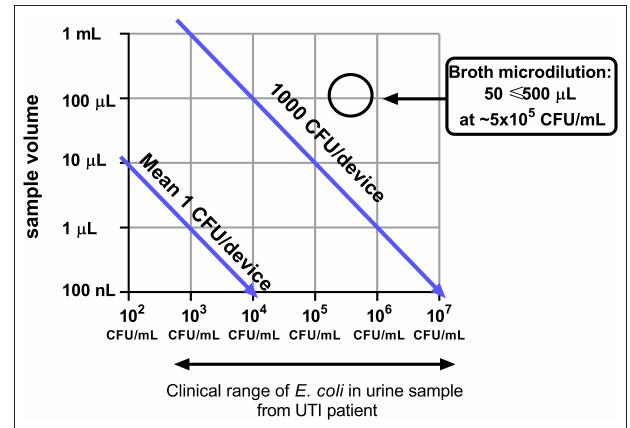
FIGURE 2 | Device miniaturization limits the number of bacterial cells sampled. Broth microdilution conditions from EUCAST are highlighted (EUCAST,